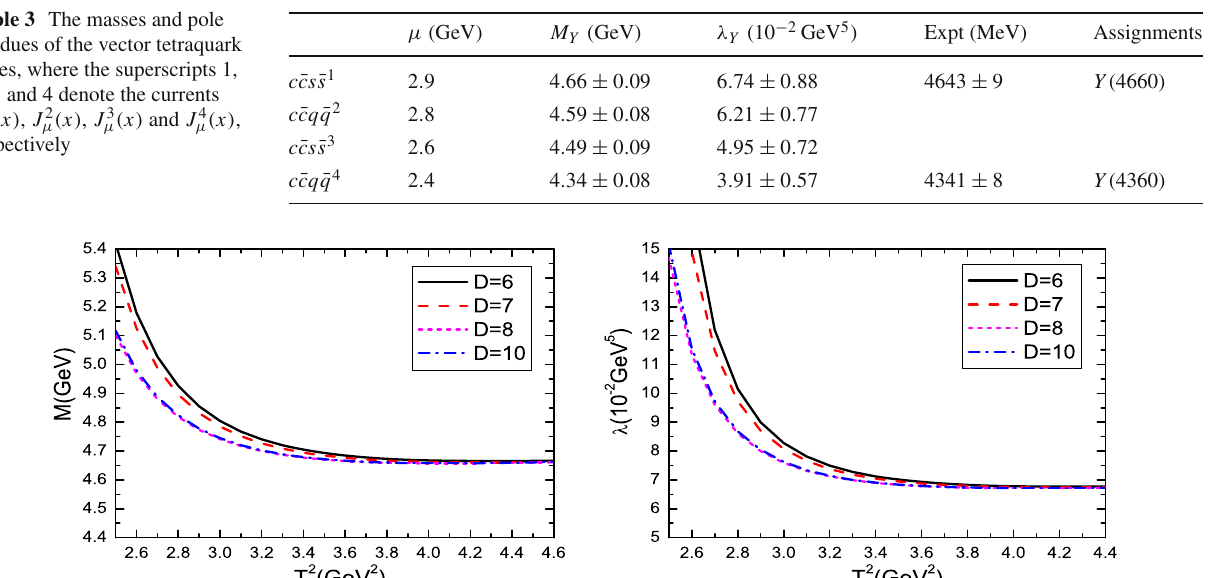
Fig. 3 The mass and pole residue of the C ⊗ γ μ C type vector tetraquark state c ¯ cs ¯ s with variations of the Borel parameter T 2 , where the D = 6, 7, 8 and 10 denote truncations of the operator product